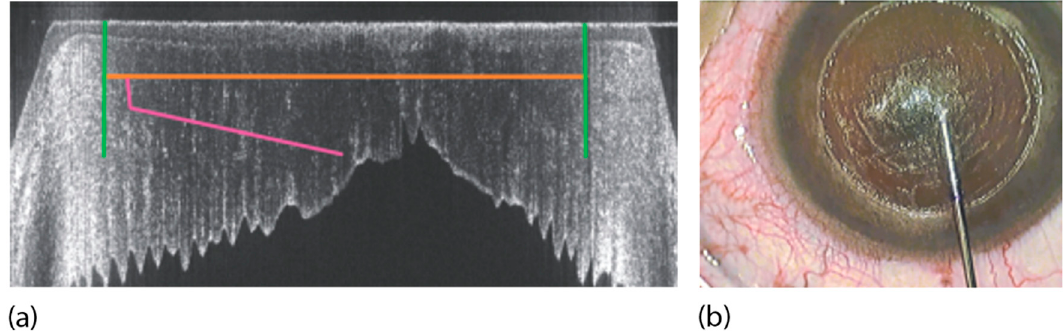
Figure 16. Deep anterior lamellar keratoplasty (DALK) procedure: ( a ) OCT-guided placement of the cuts: side cut in green, pre-Descemet’s stroma cut in orange, guiding channel in pink. The posterior cornea is folded due to the applanating docking. ( b ) Insertion of the cannula for air injection through the precut guiding channel, just above the Descemet’s membrane.